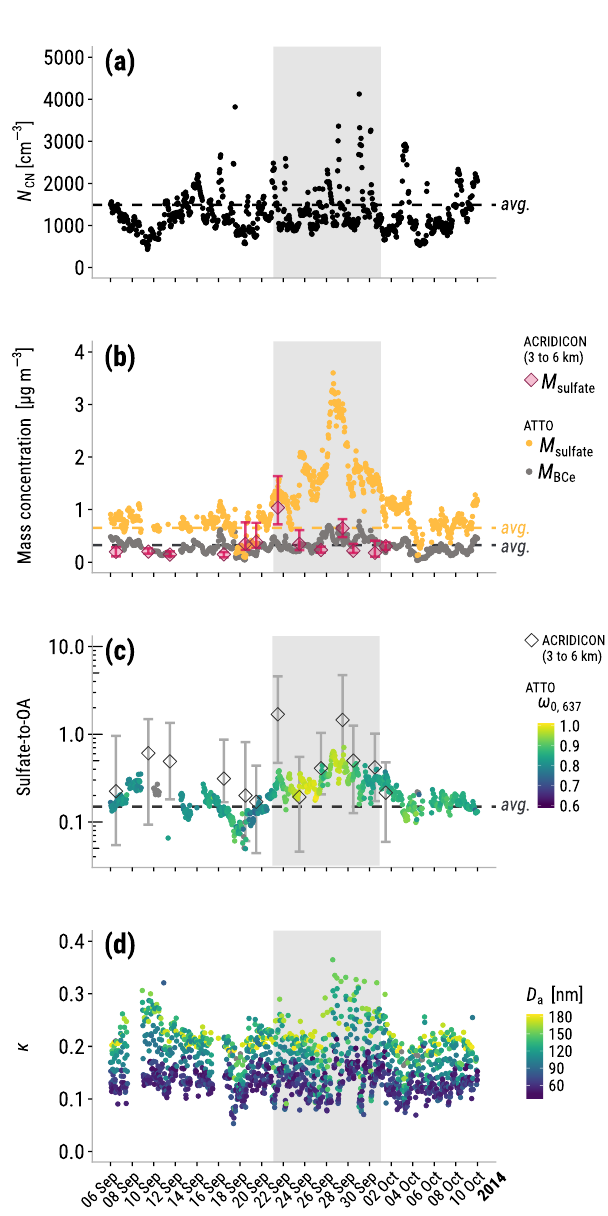
Figure 8. Different aerosol properties measured during the Nya2014 event (gray shaded area). These time series include ATTO hourly means of (a) aerosol particle number concentration, N CN , (b) sulfate and BC e mass concentration, (c) sulfate-to-OA mass ratio with color-coded aerosol particle single scattering albedo at a 637nm wavelength, and (d) hygroscopicity parameter, κ , at original time resolution with color-coded particle activation diame- ter. Dry season averages are shown as dashed lines. ACRIDICON- CHUVA flight medians and interquartile ranges from 3 to 6km of altitude are shown in (b) and (c)